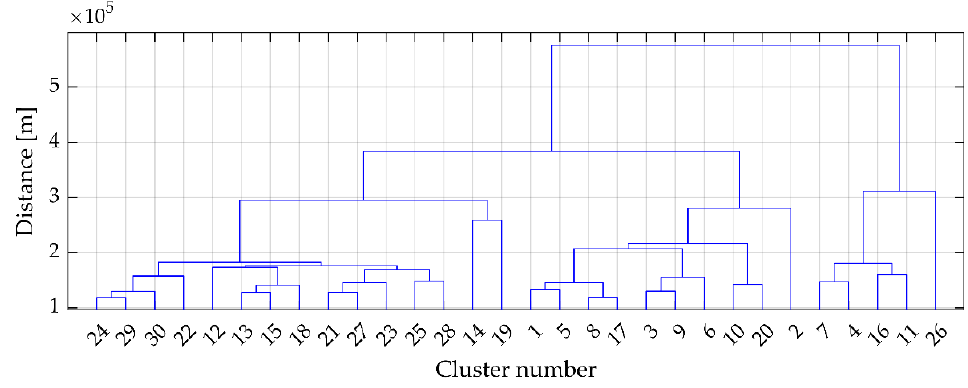
Figure 5. Dendrogram showing exemplary clustering of radar data. The diagram shows the created cluster hierarchy starting at a distance of 1000 m to ease visibility. All closer data points or cluster combinations are omitted. The blue horizontal connections represent the combination of two subclusters or values at a given distance. Note that the large distance of 1000 m resulted from the stretching process performed before.